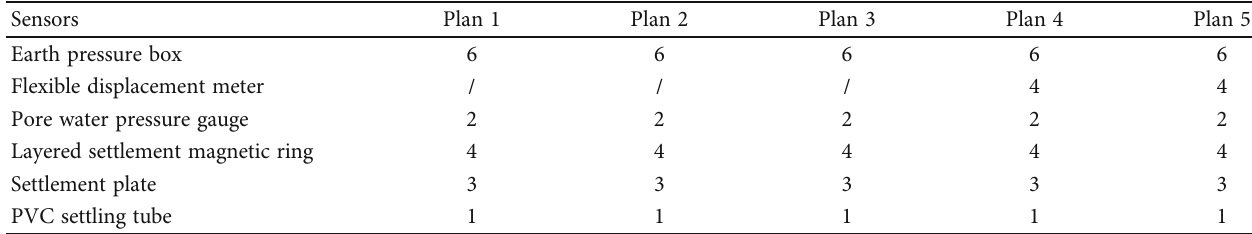
Table 3: The quantity of embedded sensors in each test